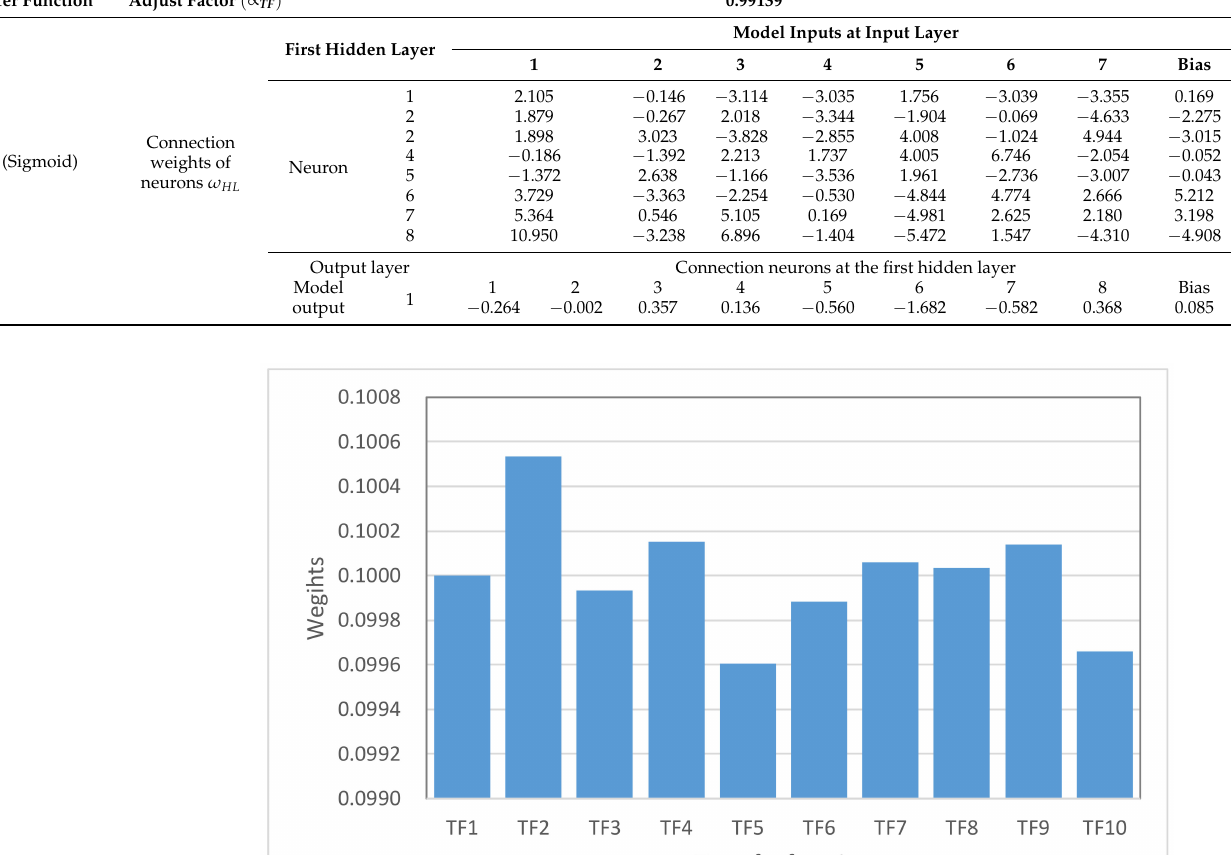
Table 5. Summary for the calibrated parameter of the SM_EID_IOT model in the study area (the Nankan River Watershed). Transfer Function Adjust Factor ( ∝ TF )